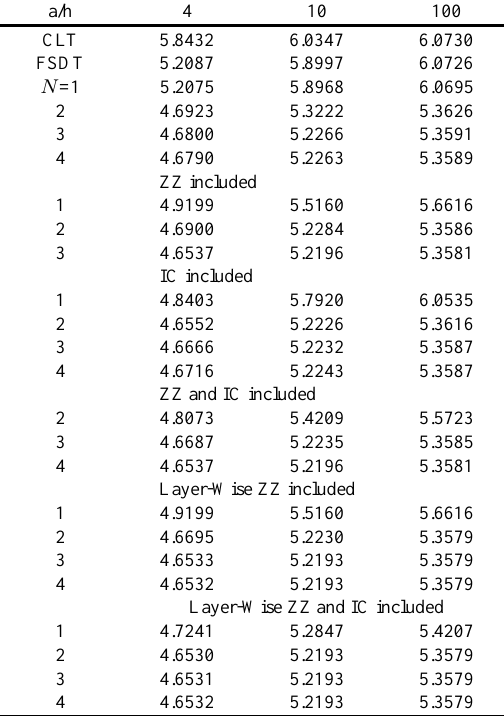
Two-layered plate made of metallic layers. ω × a (subscript 1 denotes the first layer, starting from the plate bottom). Layers data: layer 1 coincide with the metallic plate of Table 1 ( h 1 =0.001 [ m ]); the second layer is made of steel h 2 =0.002, E 2 = 210 E 09 [ Pa ], ν 2 = 0 . 3 , ρ 2 = 7800 [ kg/m 3 ]. The considered plate lengths are: a = 0 . 012 ,0.030, 0.300 [ m ]